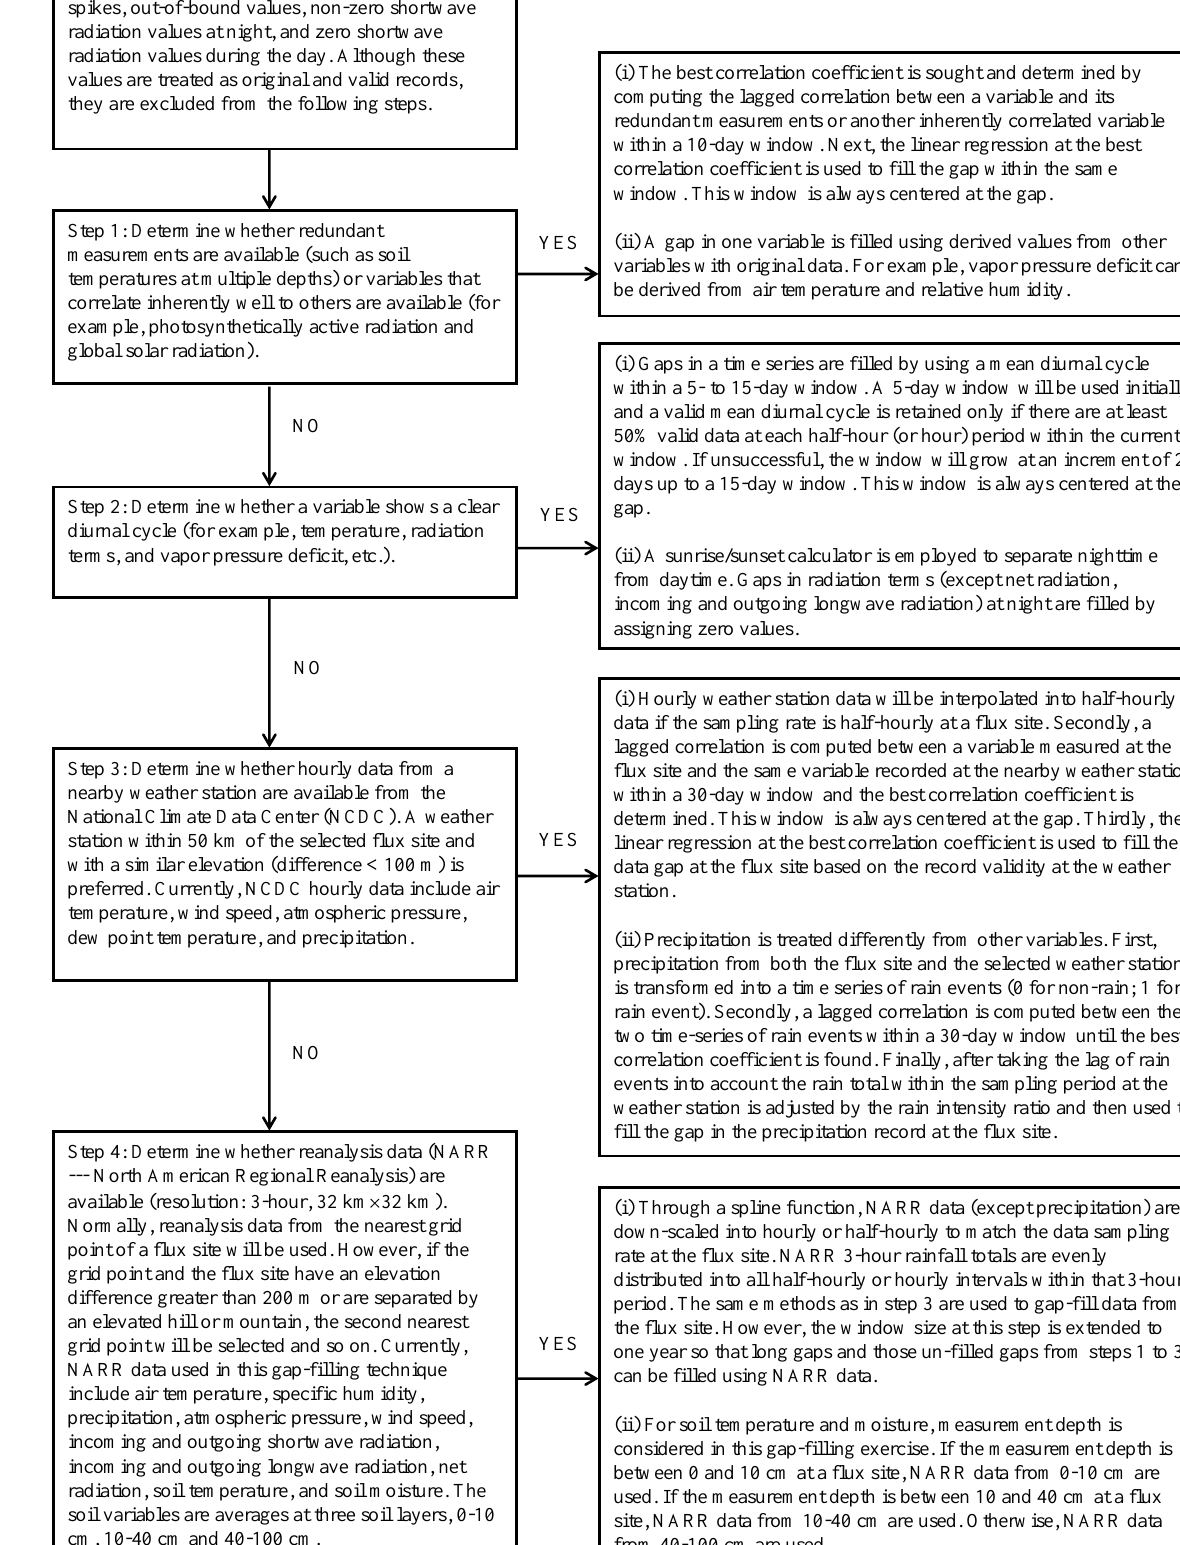
Table 3. Flow diagram for the methodology used by CDIAC to gap-fill meteorological records for the AmeriFlux network. Pre-treatment: flag potentially bad data, including spikes, out-of-bound values, non-zero shortwave radiation values at night, and zero shortwave radiation values during the day. Although these values are treated as original and valid records, they are excluded from the following